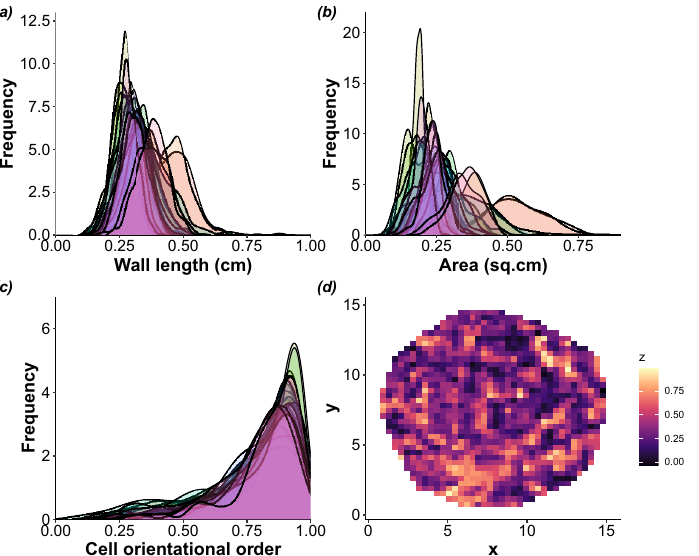
Figure 4. Frequency distribution of ( a ) cell wall lengths, ( b ) cell areas, and ( c ) cell orientational order parameter (dimensionless), depicting variation between and within the nests. ( d ) Heat map showing z = Im ψ 6 , the imaginary part of ψ 6 of cell orientational order parameter of a representative nest ( x , y in cm indicate centre of each